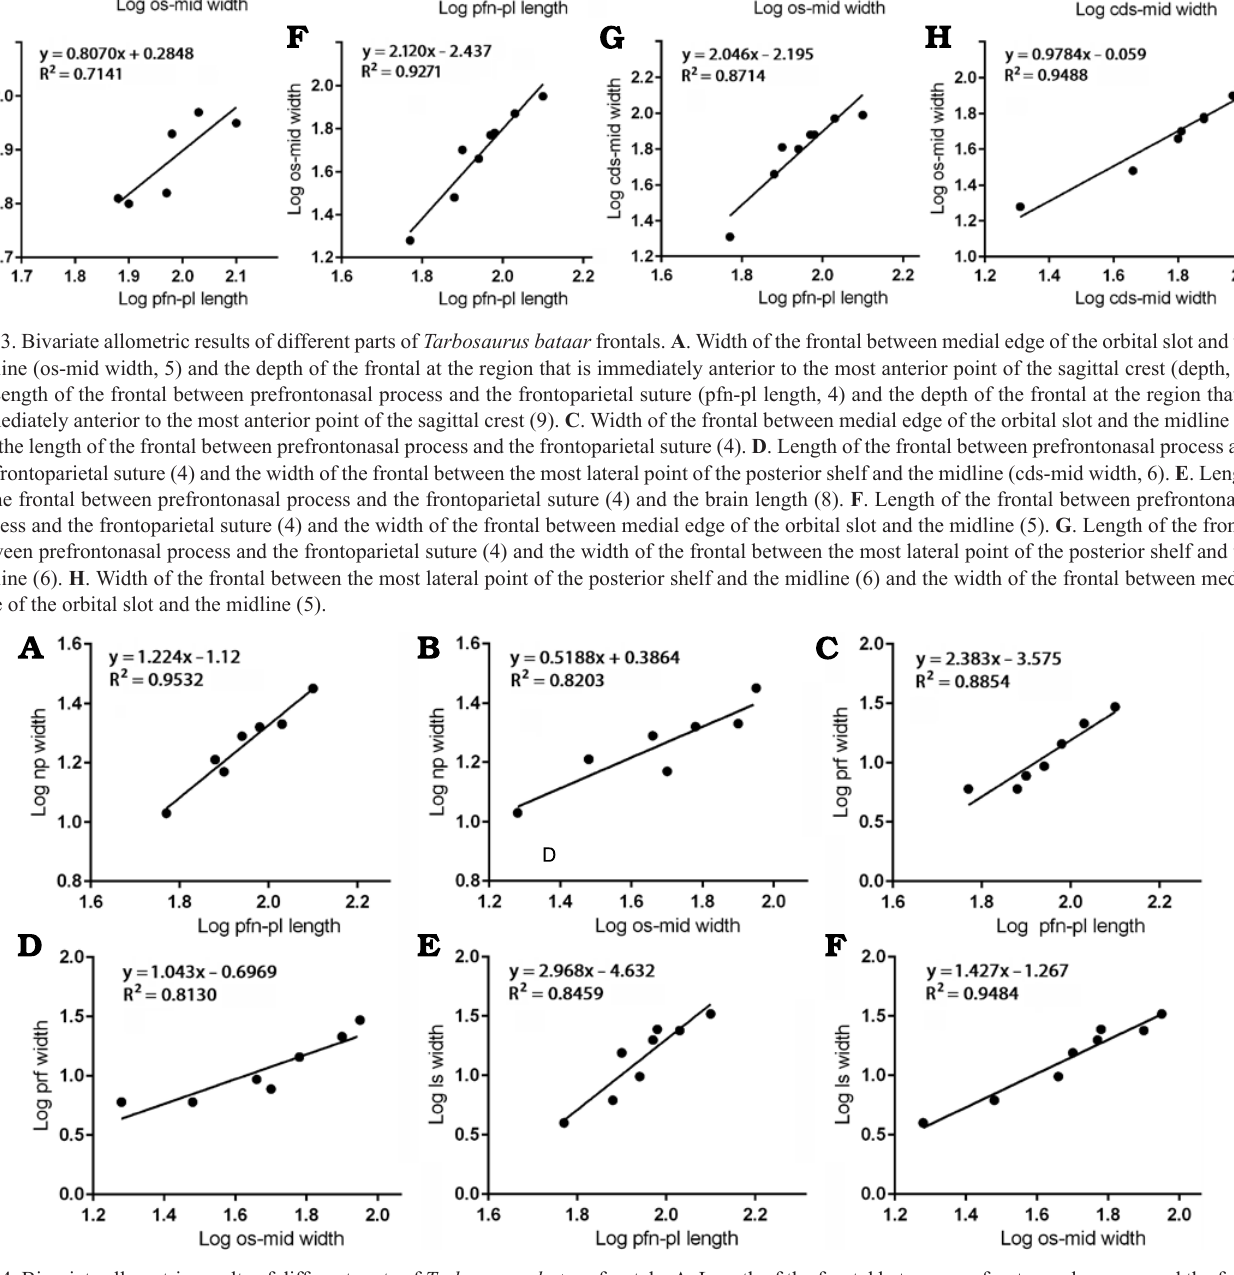
Fig. 4. Bivariate allometric results of different parts of Tarbosaurus bataar frontals. A . Length of the frontal between prefrontonasal process and the fron- toparietal suture (pfn-pl length, 4) and the width of the nasal process (np width, 1). B . Width of the frontal between medial edge of the orbital slot and the midline (os-mid width, 5) and the width of the nasal process (1). C . Length of the frontal between prefrontonasal process and the frontoparietal suture (4) and the width of the prefrontal suture (prf width, 2). D . Width of the frontal between medial edge of the orbital slot and the midline (5) and the width of the prefrontal suture (2). E . Length of the frontal between prefrontonasal process and the frontoparietal suture (4) and the width of the lacrimal socket (ls width, 3). F . Width of the frontal between medial edge of the orbital slot (5) and the midline and the width of the lacrimal socket